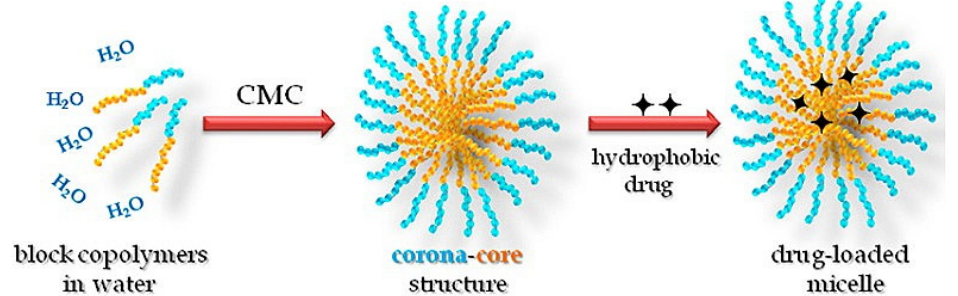
Figure 11. Schematic representation for the micellization of diblock copolymers and drug encapsulation in polymeric micelle. CMC: critical micelle concentration. Adopted from reference [245].